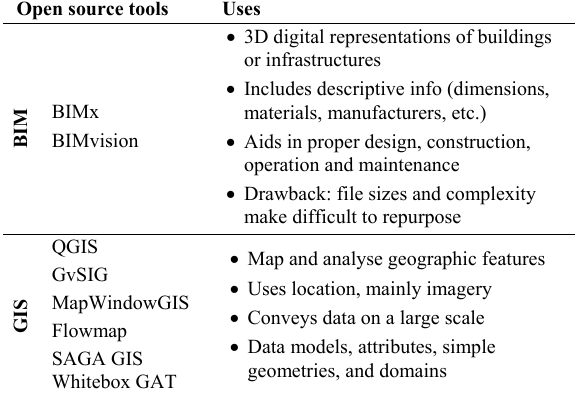
Table 5. Most common uses of BIM and GIS, and some of the open source software